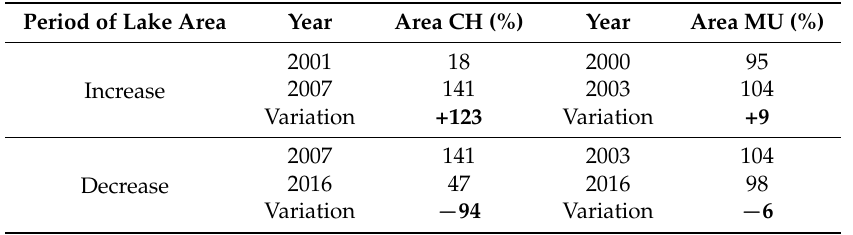
Table 3. Increasing and decreasing lake area periods calculated with Landsat images (reference samples) using a red green blue (RGB) band combination (near infrared; short wave infrared; red; Landsat 5 and 7: bands 4–5–3. Landsat 8: bands 5–6–4).